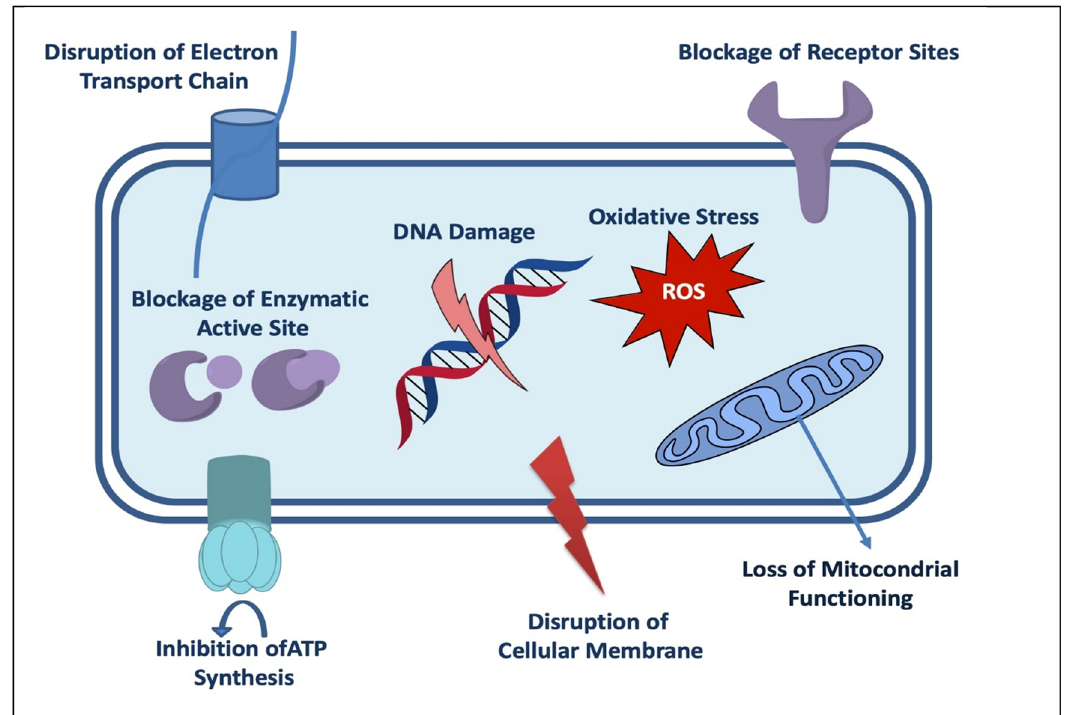
Figure 4: Possible antimicrobial mechanism of plant - mediated SeNPs ( adopted from ref. [ 11 ])